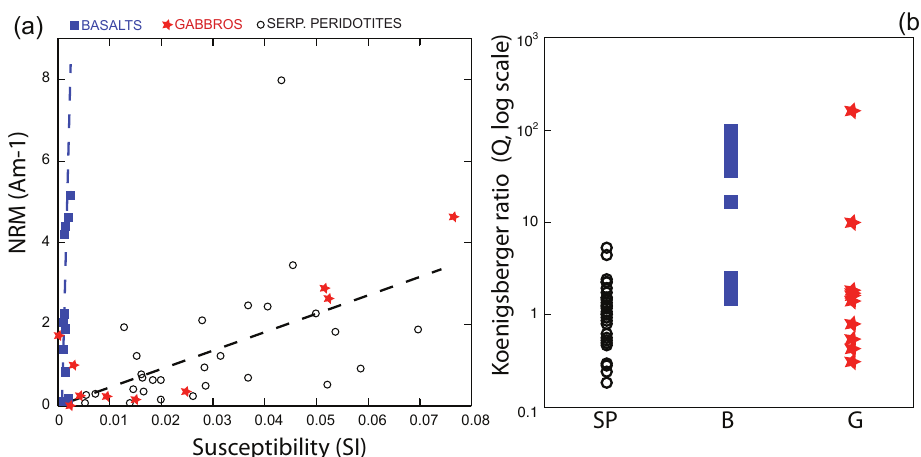
Figure 5. (a) Natural remanent magnetization (NRM) from dredged peridotites, basalts and gabbros as a function of the magnetic sus- ceptibility ( K ). (b) Koenigsberger ratio ( Q ) for serpentinized peridotites (SP), basalts (B) and gabbros (G). Note that Q has a logarithmic